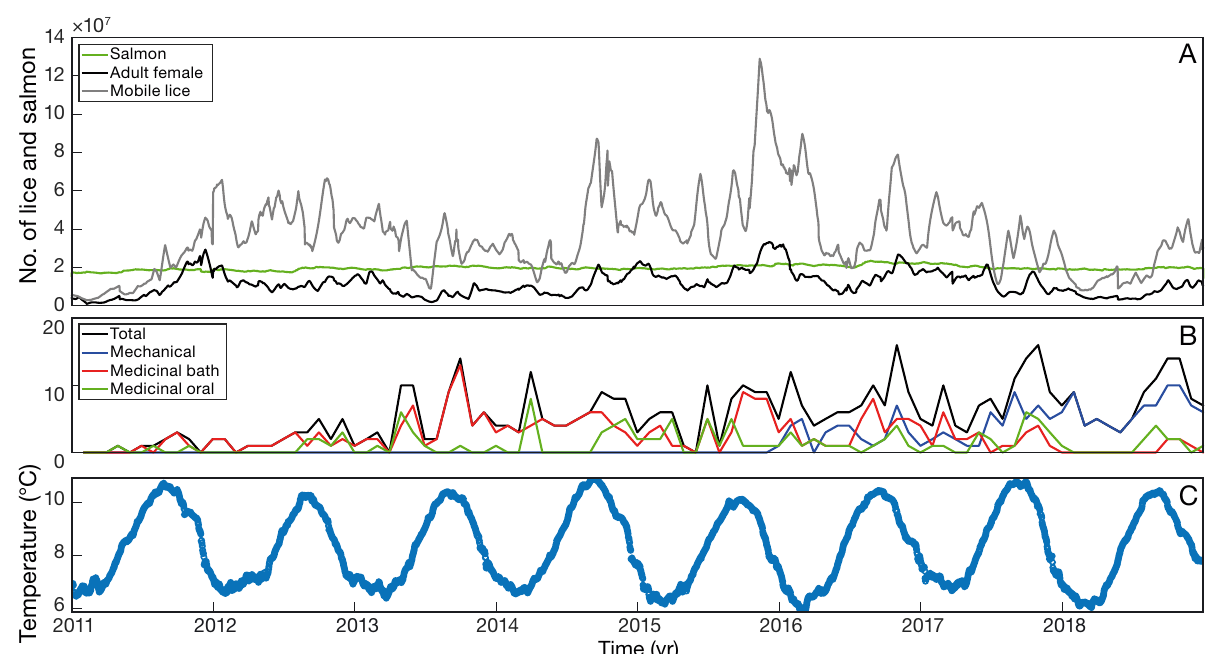
Fig. 2. (A) Total number of gravid lice, other mobile lice and salmon in the Faroe Islands. (B) Number of treatments in the Faroe Islands per month shown as total, mechanical, medicinal bath and medicinal oral treatments. (C) Faroese shelf temperature. Data are shown for the period from 2011 to 2018